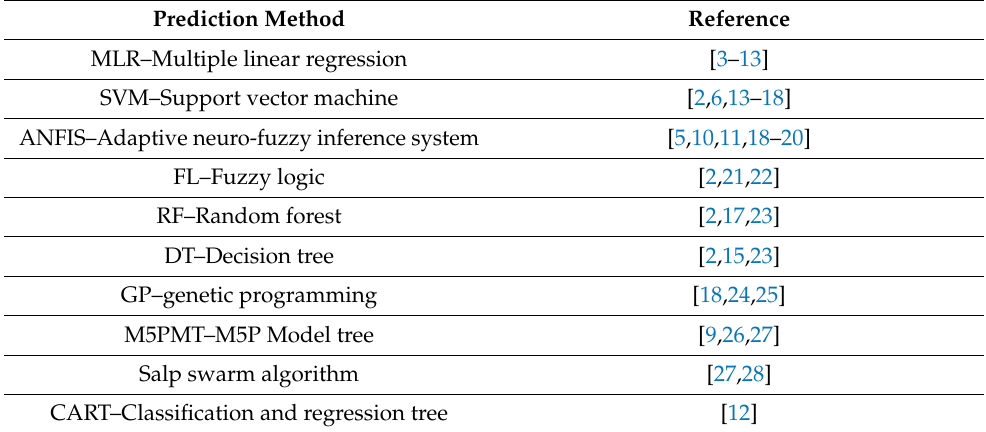
Table 1. Investigations which compare ANNs to other methods for prediction of concrete behavior.